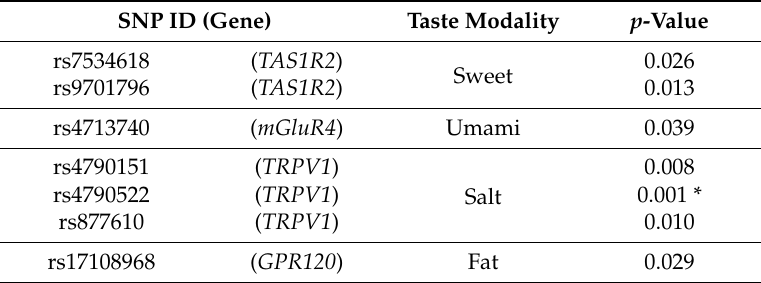
Table 5. Associations between SNPs in taste receptor genes and taste preference in